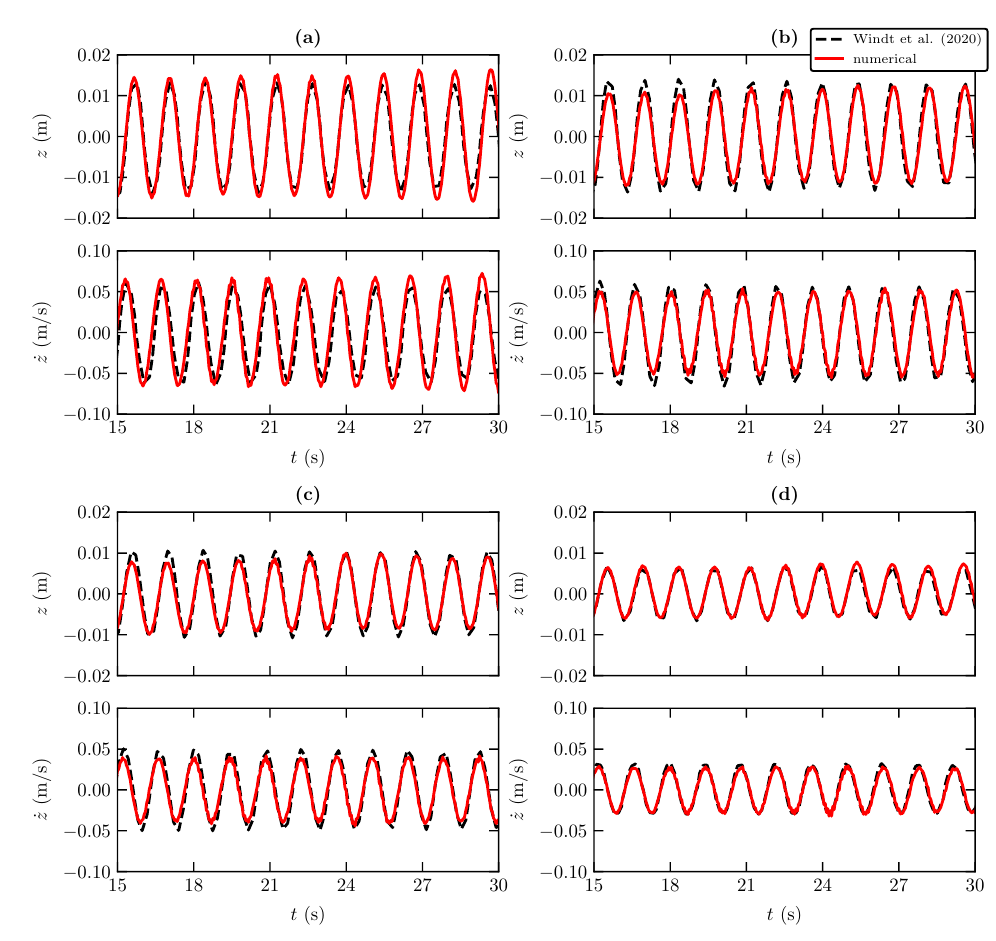
Figure 3. Time series of position (top) and velocity (bottom) of the PTO system for Test 1 with ( a ) D = 0, ( b ) D = 50 Nms, ( c ) D = 100 Nms and ( d ) D = 200 Nms [43].